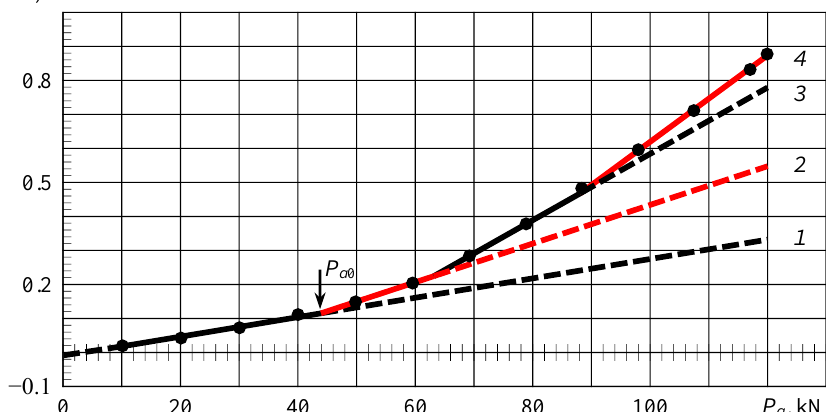
Fig. 4. Amplitude dependence of the disclosure of the inelasticity loop of one of specimens from carbon fiber reinforced plastic Torayca T700 with orthogonal laying: 1 – relaxation type inelasticity, 2 - 4 – addition of inelasticity loop disclosure due to the appearance of local plastic strains appearing in different places of the material